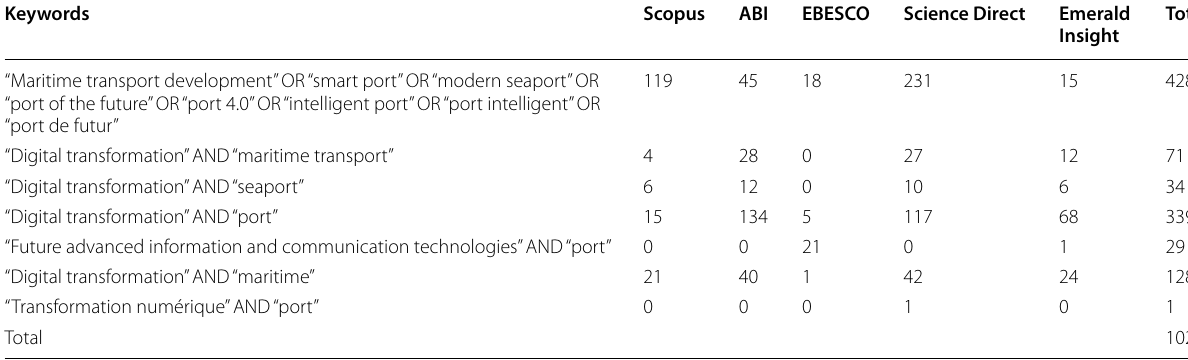
The total review yielded a total of 1022